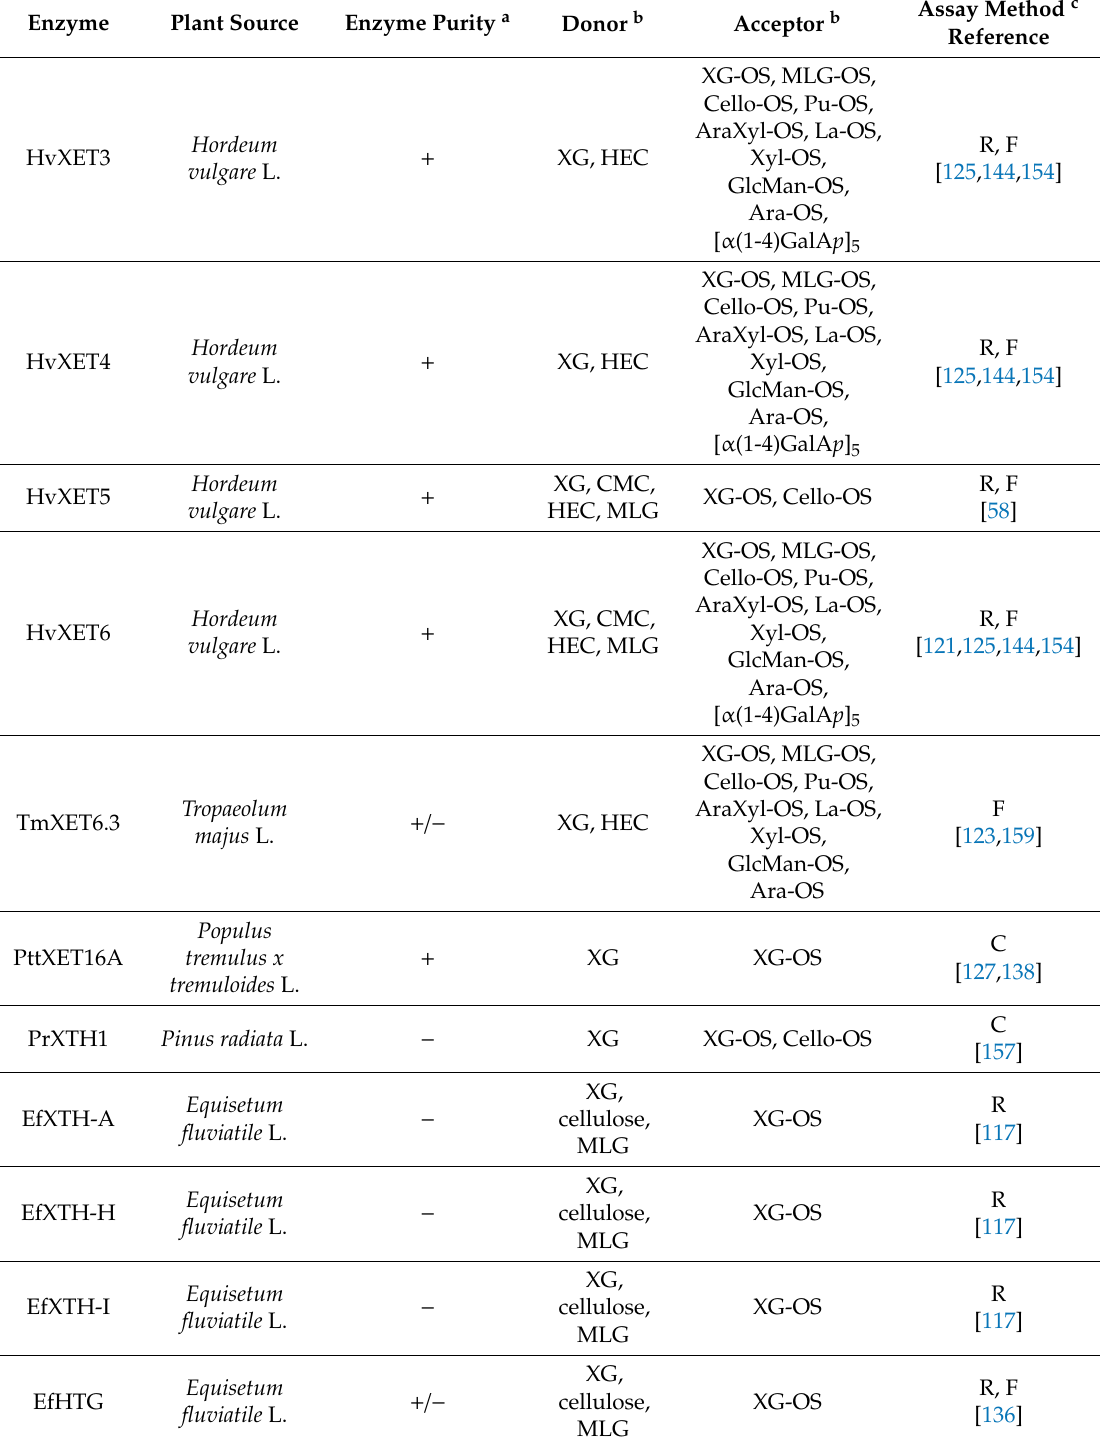
Assay Method c Reference XG-OS, MLG-OS, Cello-OS, Pu-OS, AraXyl-OS, La-OS,